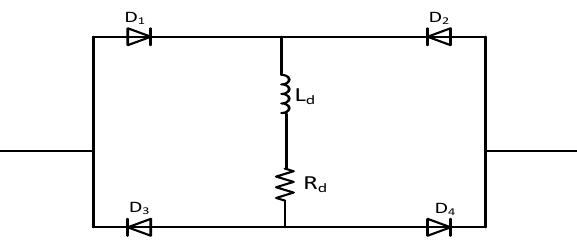
Figure 11. Direct current (DC) link fault current limiter.